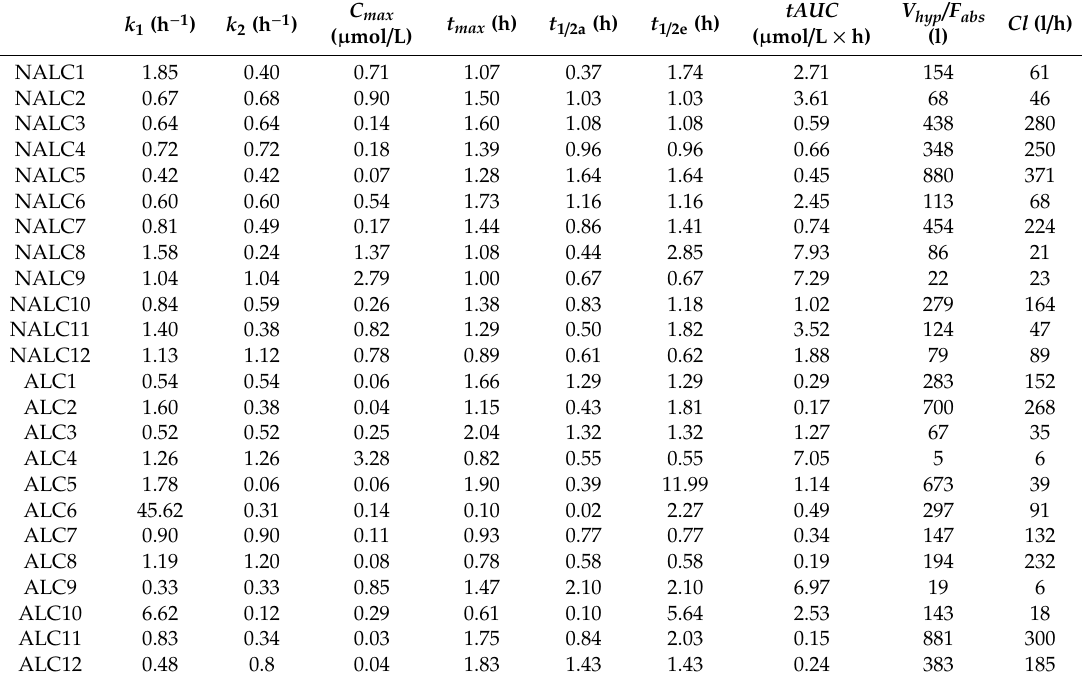
Table 3. Plasma kinetics of epicatechin in individual subjects after ingestion of a beverage prepared with nonalkalized and alkalized